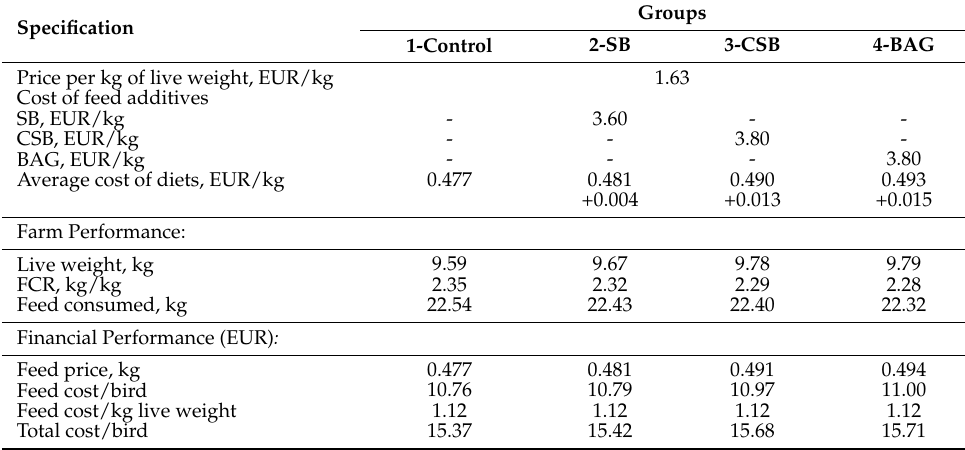
Table 5. Economic evaluation (per